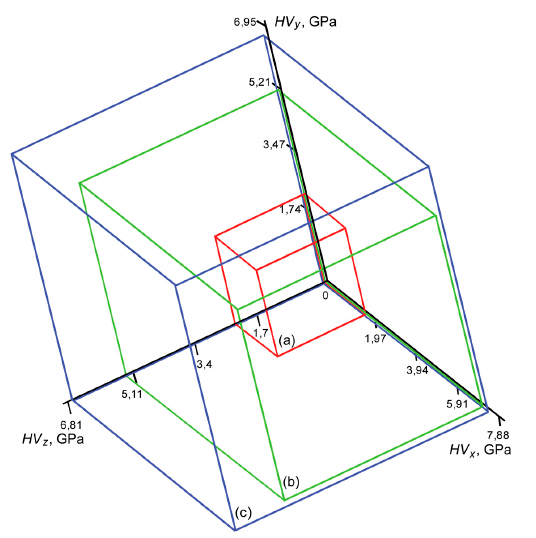
Figure 17. Behavior of microhardness HV of the Cu-Nb nanocomposites in three mutually orthogonal directions as a function of the degree of deformation: before HPT at N = 0 ( a ); after HPT to N = 2 ( b ) and N = 4 ( c ), respectively.